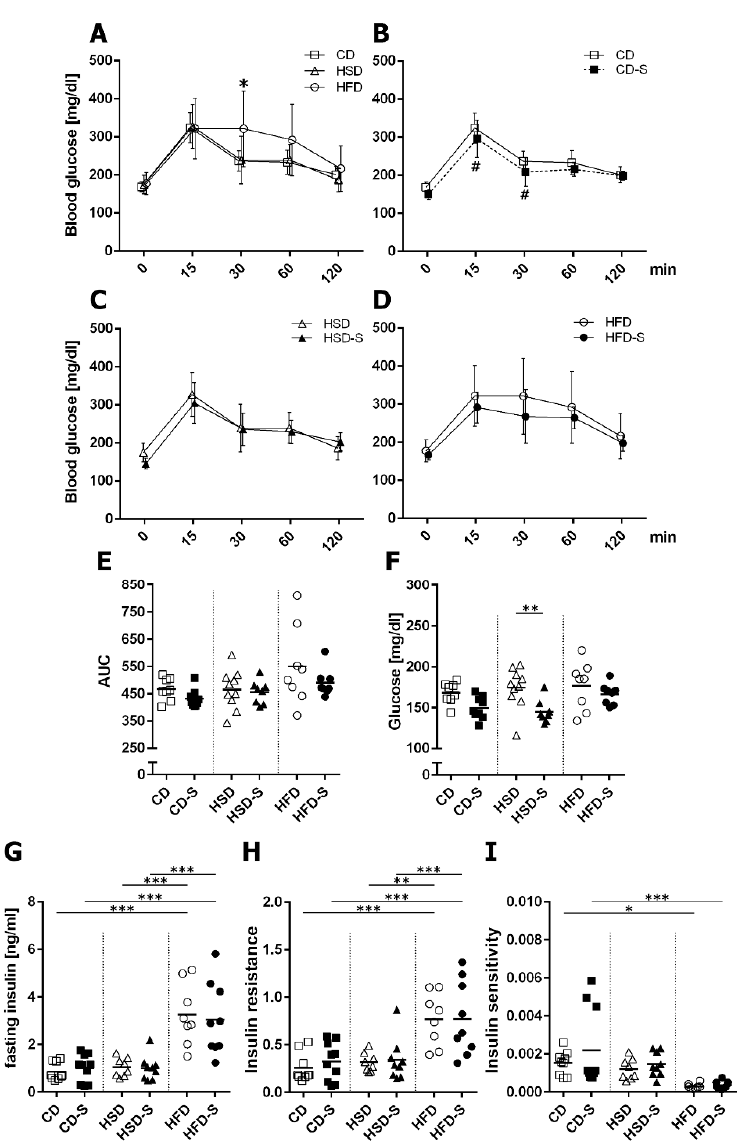
Figure 3. Effects of diets and spermidine on glucose homeostasis. ( A ) Diet-related effects on glucose tolerance. ( B – D ) Spermidine-related effects on glucose tolerance in respective diet groups. ( E ) Area under the curve (AUC) values for glucose tolerance curves. ( F ) Fasting plasma glucose concentra- tions. ( G ) Fasting plasma insulin concentrations. ( H ) HOMA insulin resistance related to body weight. ( I ) Insulin sensitivity measured by 1/insulin related to body weight. ( A – D ) Values are group means ± SD; CD n = 10, CD-S n = 10, HSD n = 10, HSD-S n = 9, HFD n = 8, HFD-S n = 9; data were compared separately for diet and spermidine effects by 2W-RM-ANOVA followed by Tukey test; p -values < 0.05 are indicated by * for dietary effect or # for spermidine effect. ( E – I ) Data shown as values of individual mice, group means are indicated by horizontal lines; data were compared by 2W-ANOVA followed by Tukey test; * p < 0.05, ** p < 0.01, *** p < 0.001. CD, control diet; HSD, high sucrose diet; HFD, high fat diet; -S, spermidine. Both high sucrose and high fat intake resulted in significantly elevated total choles- terol, high-density lipoprotein (HDL) cholesterol and low-density lipoprotein (LDL) cho-